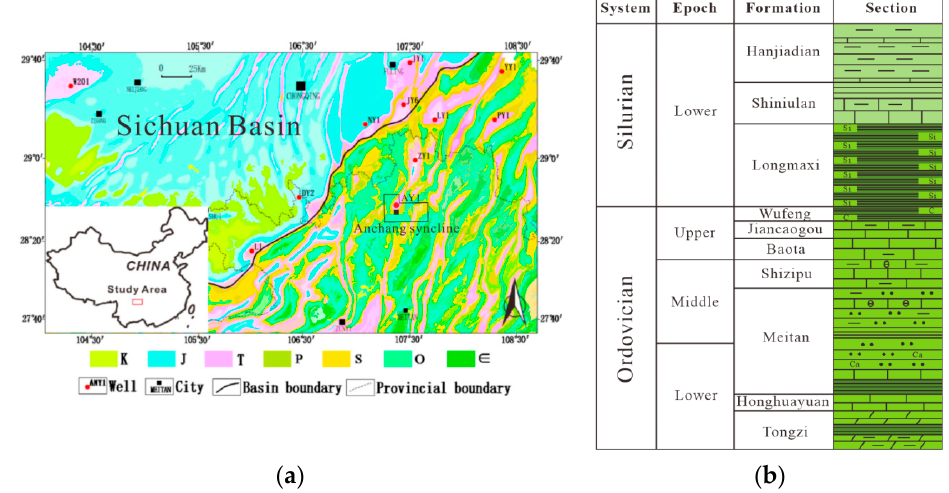
Figure 1. ( a ) The geological map of the Sichuan Basin and the Anchang Syncline. ( b ) The integrated stratigraphic column of the Anchang Syncline from Ordovician to Silurian.